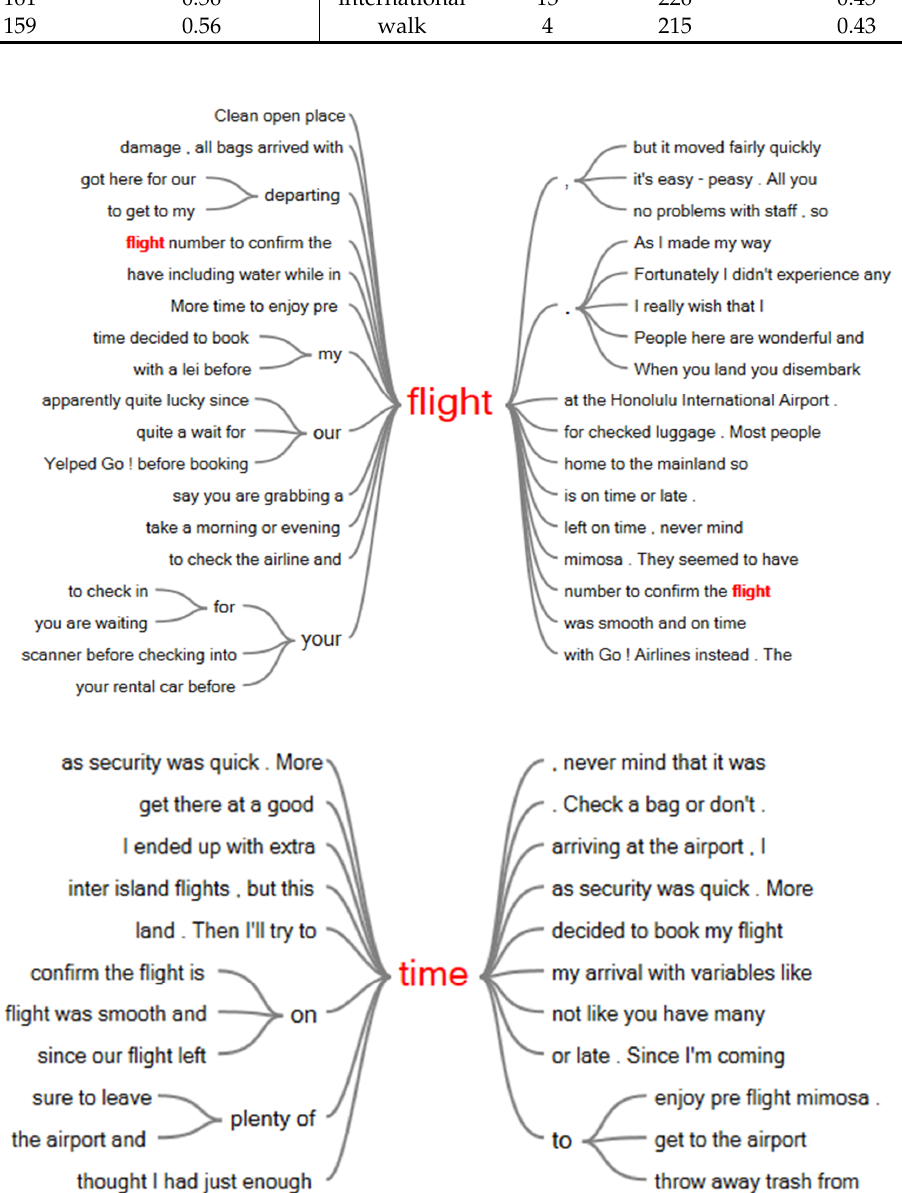
Figure A1. Word Trees “Flight” and “Time” for Satisfied Travelers at HIA.